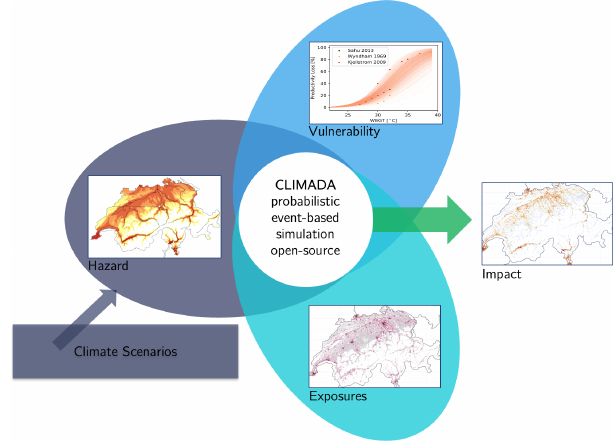
Figure 1. IPCC risk framework applied to the modelling of heat impact on labour productivity in CLIMADA (Aznar-Siguan and Bresch,